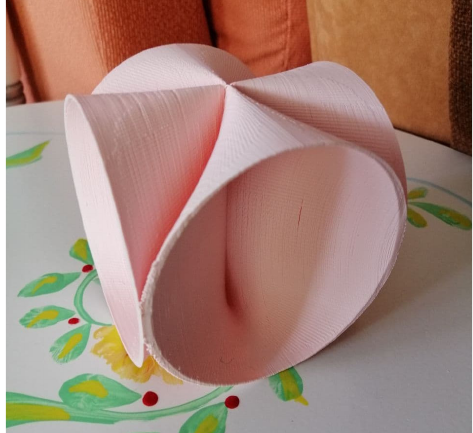
Figure 35. The Dyosphera in 3D print, detail of interlocks.